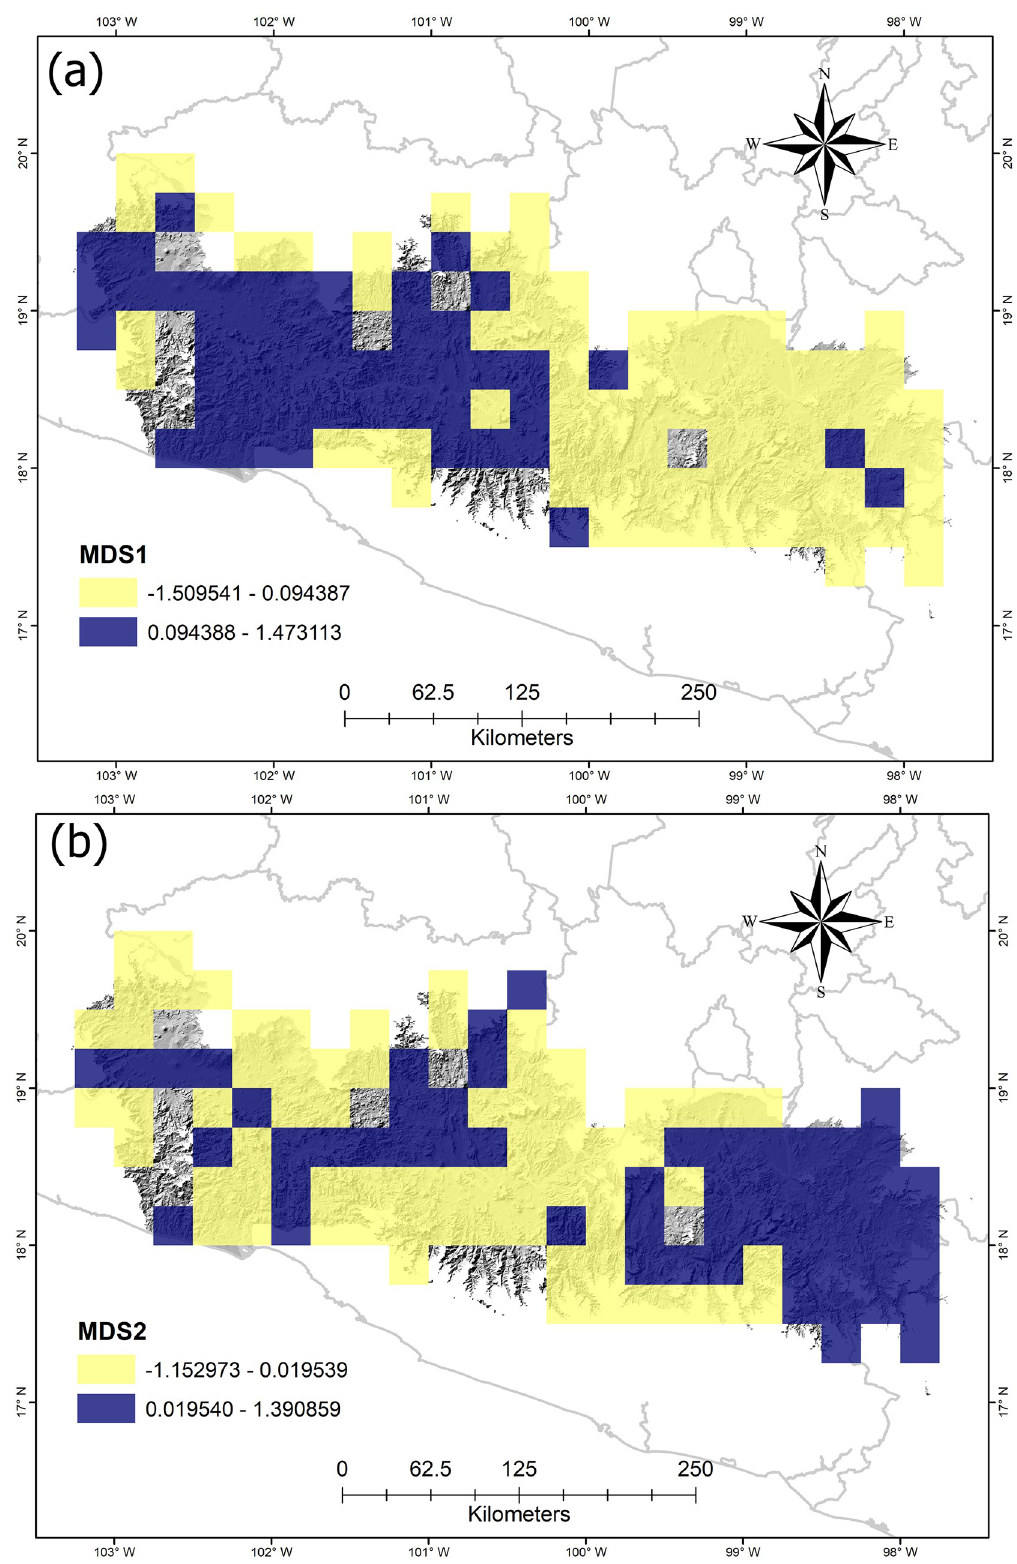
Fig 5. Asteraceae species turnover measured with the non-metric multidimensional scaling method (NMDS) for (a) axis 1 (NMDS1) and (b) axis 2 (NMDS2). The colors mark the two turnover ordering classes. https://doi.org/10.1371/journal.pone.0253152.g005 PLOS ONE | https://doi.org/10.1371/journal.pone.0253152 June 15,